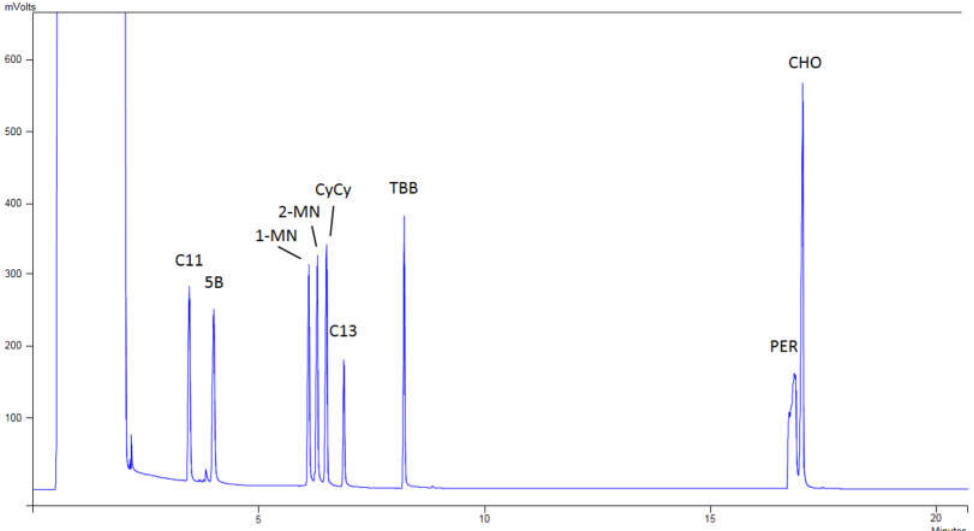
Figure 2. Chromatogram of the mixture of internal standards of Restek spiked at 10 mg/kg in n